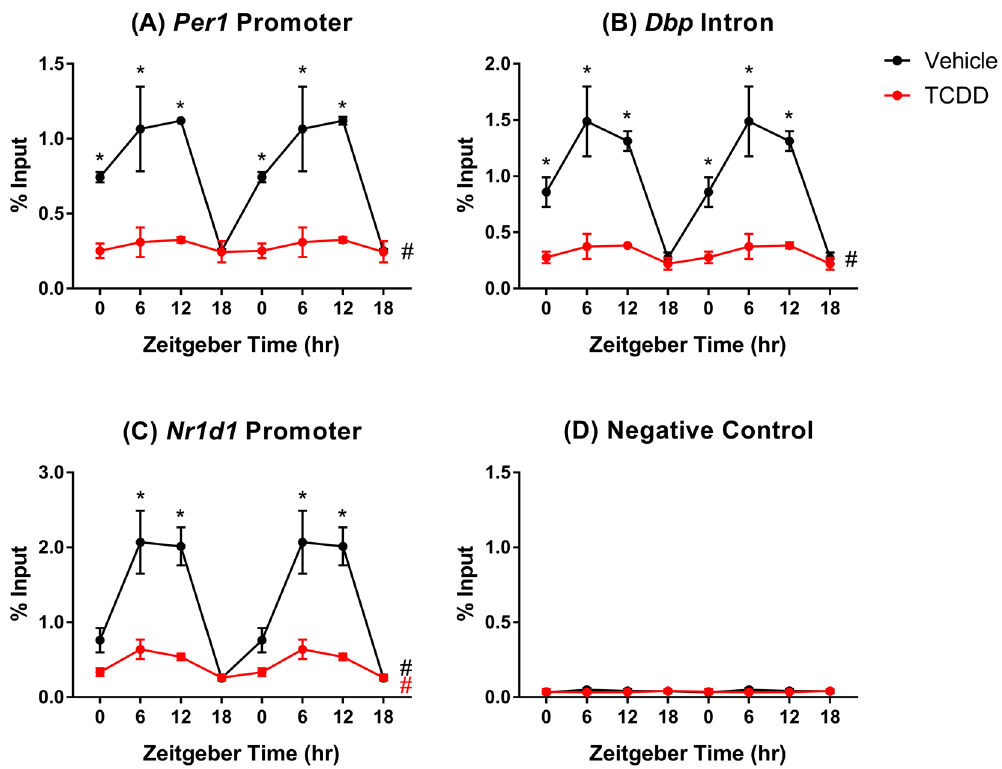
Figure 6. ARNTL genomic enrichment within target genes assessed using chromatin immunoprecipitation (ChIP). Liver samples were collected from male C57BL/6 mice following oral gavage with sesame oil vehicle or 30 µ g/kg TCDD every 4 days for 28 days. Genomic enrichment for ARNTL was quantified by qRT-PCR using primers targeting previously identified ARNTL binding sites within ( A ) the Per1 promoter (site 2), ( B ) a Dbp intron, and ( C ) the Nr1d1 promoter as described in Supplementary Table S2. ( D ) A negative control region on chromosome 6 was used to confirm the specificity of the ANRTL immunoprecipitation. Data points represent the average % input of 3 individual mice ± standard error of the mean. Statistical significance ( * p ≤ 0.05) between vehicle- and TCDD-treated mice was determined using a two-way ANOVA analysis followed by Sidak’s multiple comparison test. Diurnal rhythmicity was assessed using JTK_CYCLE (# BH q ≤ 0.1). Data are double-plotted along the x-axis for better visualization of